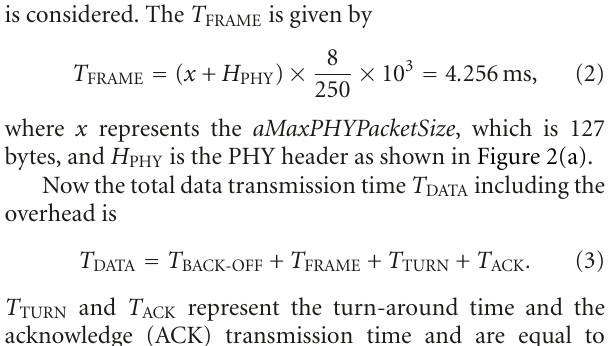
transmits the RSSI value to the base station after 30 seconds session. In [1], the RSSI is calculated for 15 decimal